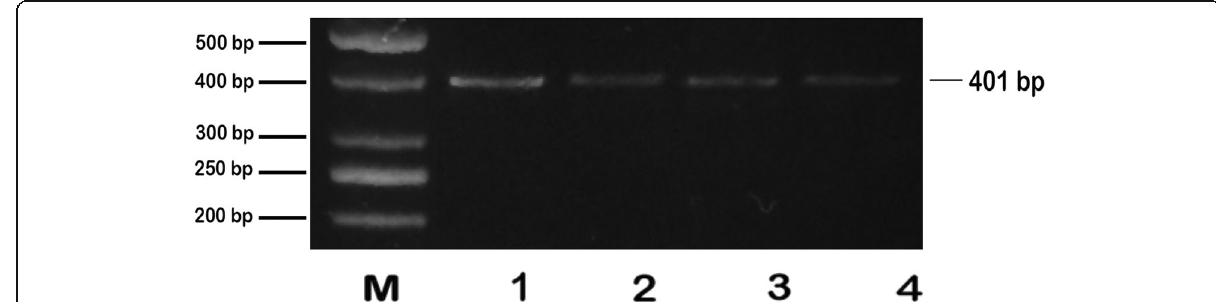
Fig. 1 The electrophoretic pattern of PCR amplification of DGAT1 gene fragment. M, 50 bp ladder marker. Lanes 1 – 4, 401 bp PCR product of DGAT1